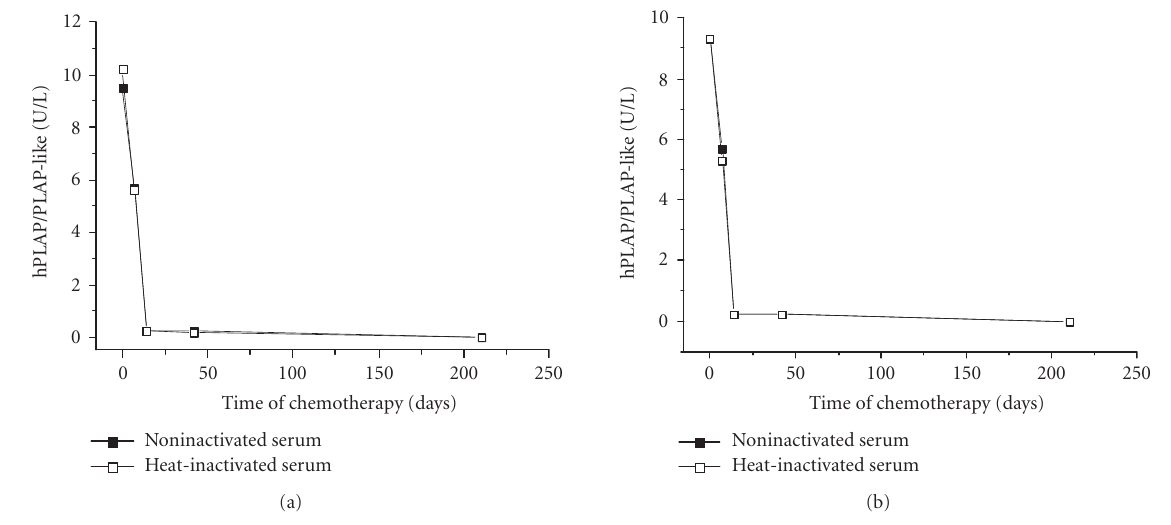
Figure 3: hPLAP/PLAP-like activities in the sera of a 11 . 2-year-old child with embryonal carcinoma measured by (a) ICA-PLAP and (b) ICA-PEP assays. Forty-two days after initiating chemotherapy a CT scan revealed evidence of complete tumor